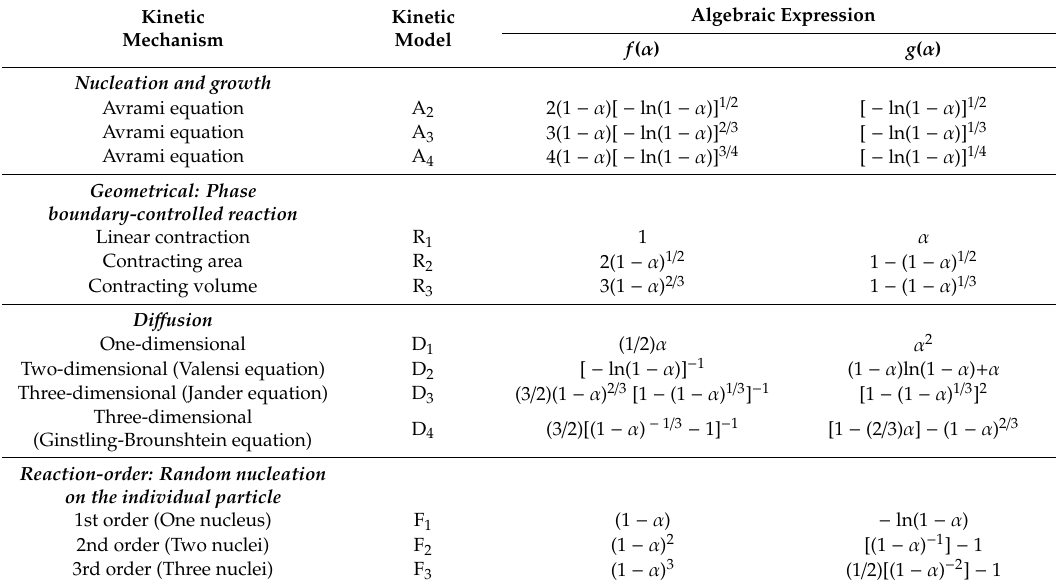
Table 1. Algebraic expressions of the kinetic models for f ( α ) and g ( α ) for kinetic mechanisms of solid-state processes